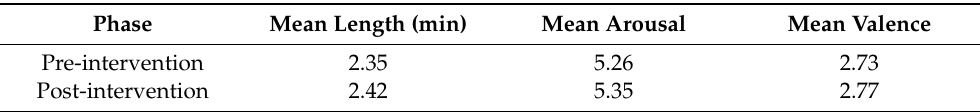
Table 1. Mean values of emotional video clips used during experiment in the pre- and post- intervention